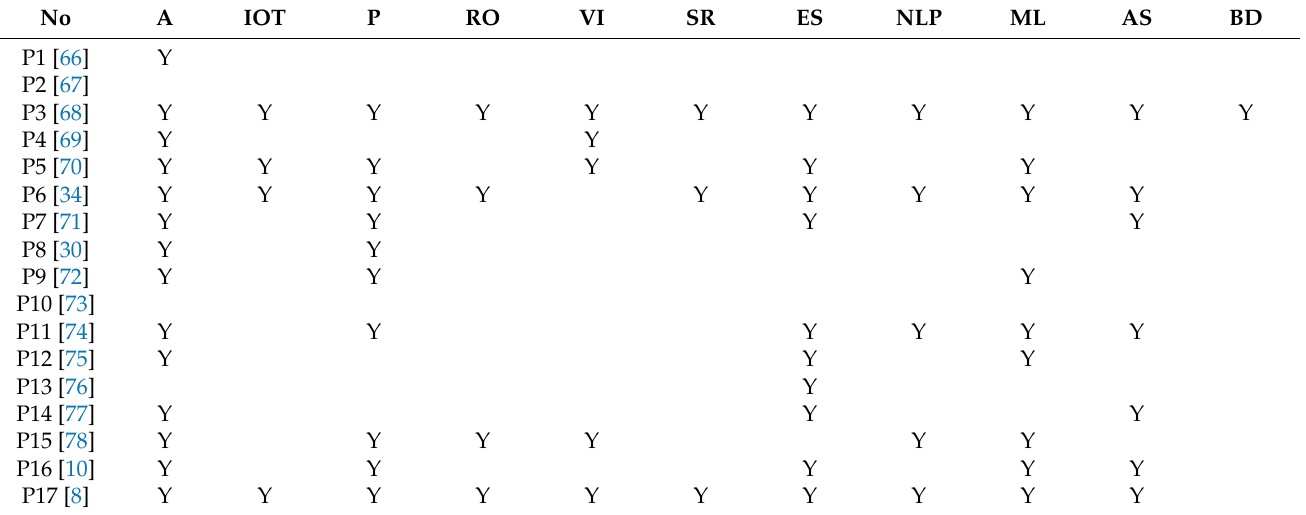
Table 7. AI of previewed